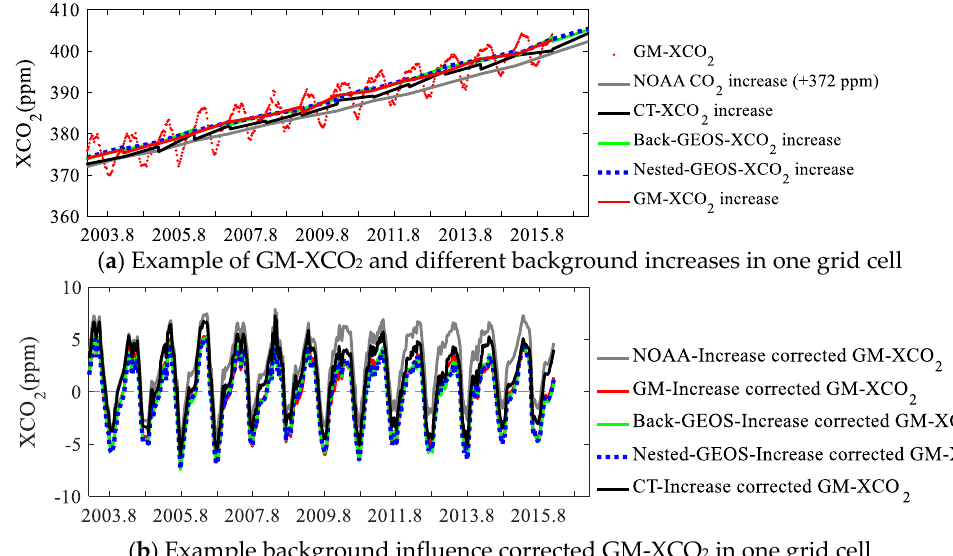
Figure 3. Example of GM-XCO 2 trend “correction” methods aimed at removing remote and local non-biospheric CO 2 flux influence from an individual grid cell (Lat: 38.5°N; Lon: 115.5°E). ( a ) GM-XCO 2 (red points) and different XCO 2 background characterizations: National Oceanic and Atmospheric Administration (NOAA) surface CO 2 increase (grey line) is calculated from the NOAA mean global CO 2 growth rate (+372 ppm), CT-XCO 2 (black line), Back-GEOS-XCO 2 (green line), Nested-GEOS-XCO 2 (blue dashed line) and GM-XCO 2 increase (red line) are the fitted results using corresponding XCO 2 and equation 4. ( b ) Corrected GM-XCO 2 time series after removing the background characterizations from panel a. Same color key as above.